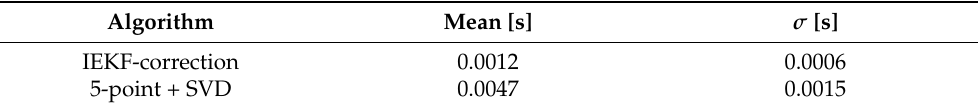
Figure 14. Distribution of execution times for the 5-point algorithm and pose recovery through SVD decomposition of the essential matrix and chirality check. Table 4. Execution times for different approaches: IEKF (this work) and 5-point + SVD decompo- sition. The IEKF elapsed time refers to the computation of the implicit constraint and the relevant covariance